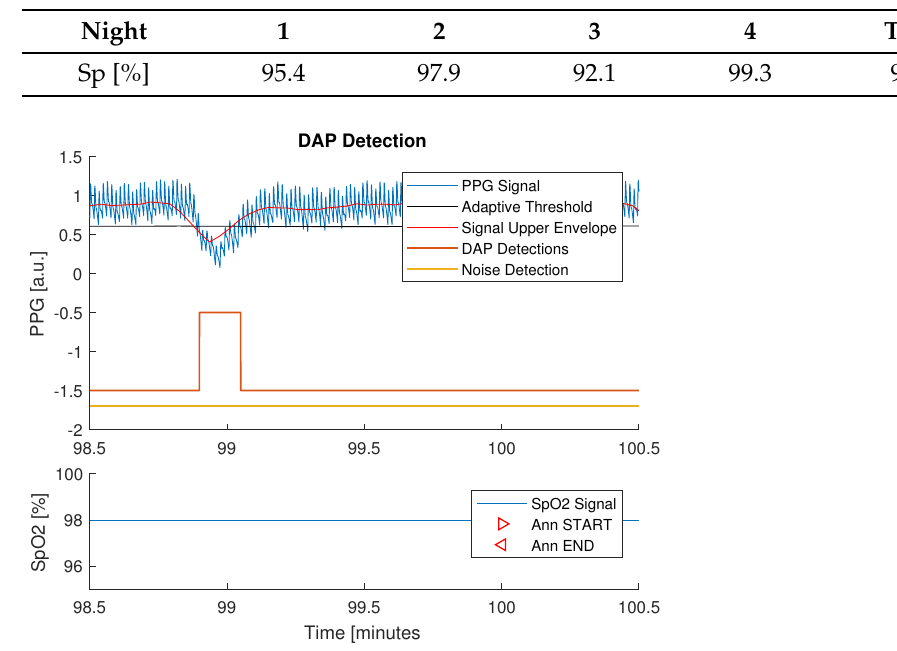
Table 8. Apnea and hypopnea detection applied on a healthy subject.